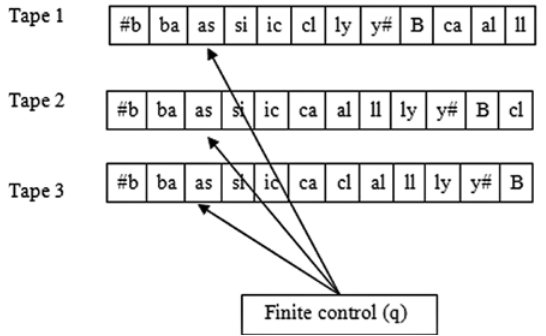
Figure 5: Implementation of NGE using Turing